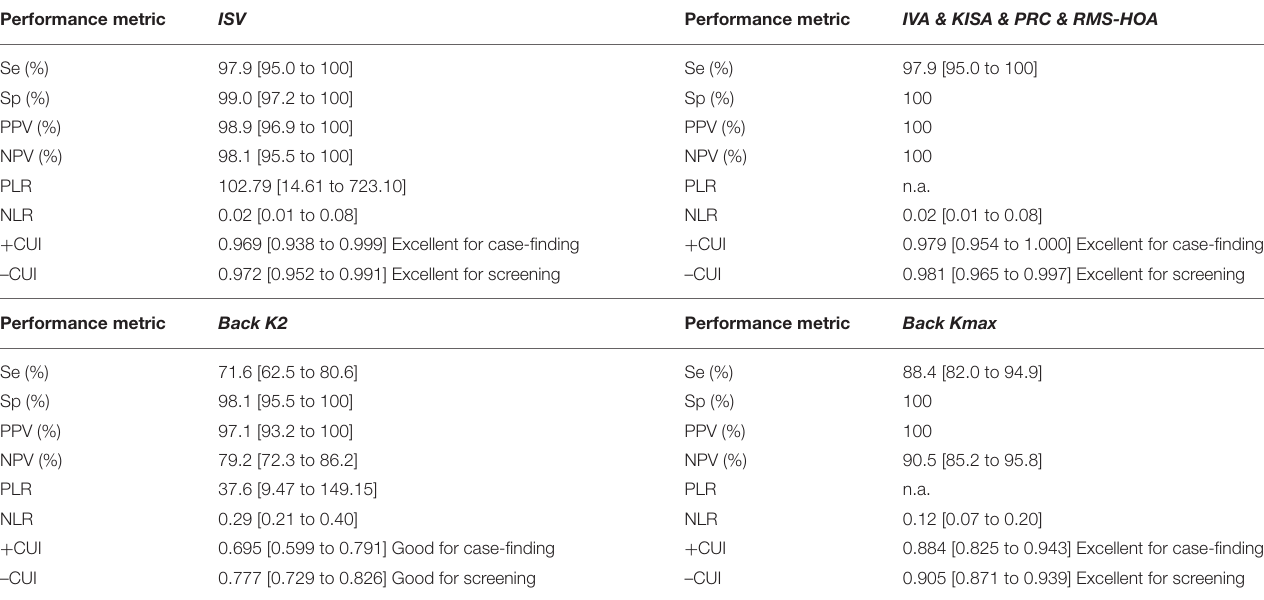
TABLE 8 | Performance analysis of Pentacam indices as diagnosis tools: KCN vs.